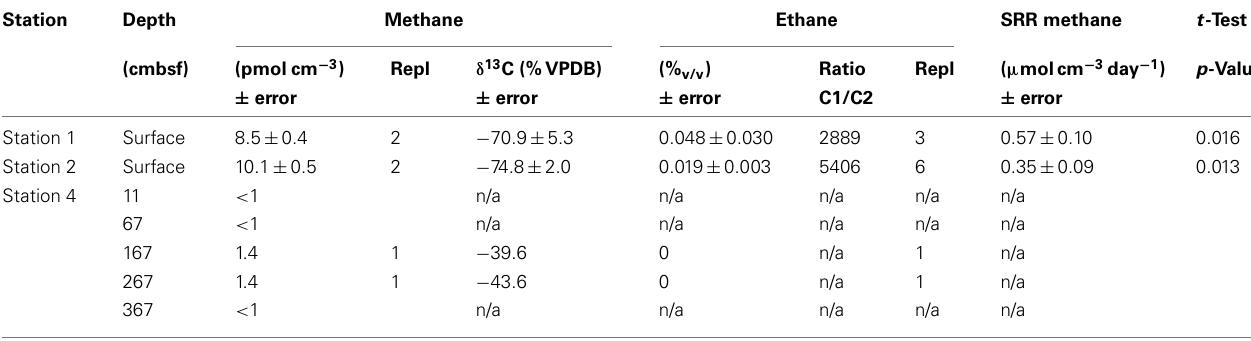
Table 3 |Analyses of in situ gas and microbialAOM activity in sediments of the Simeulue seep.